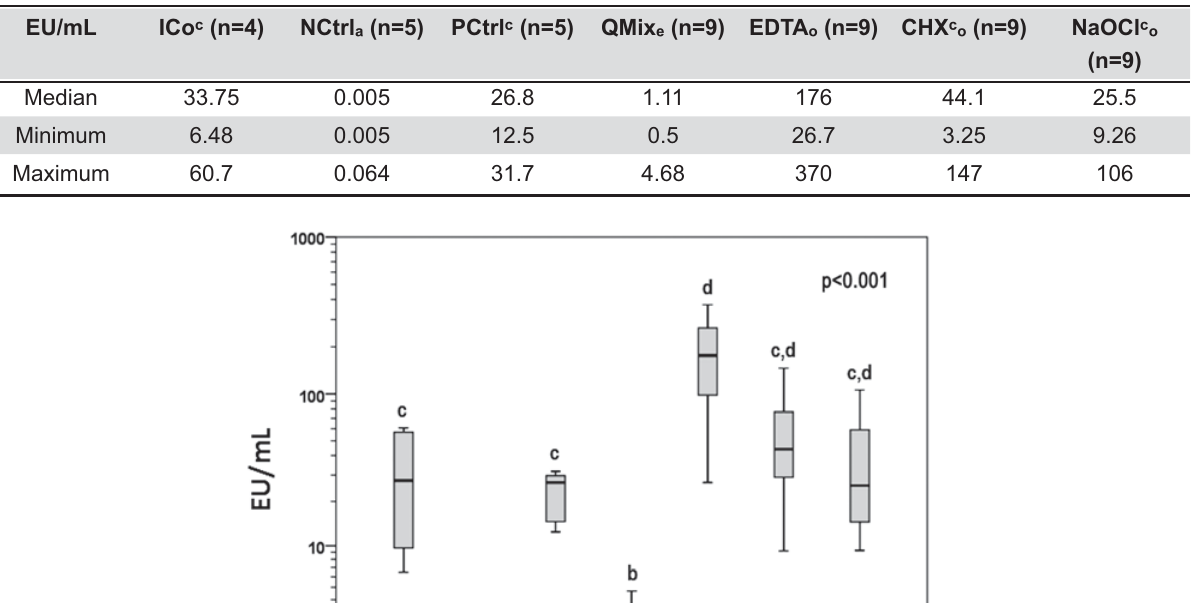
Table 1- (cid:4)&(cid:8)(cid:22)(cid:19)(cid:15)(cid:19)’(cid:7)(cid:8)(cid:4)(cid:30)(cid:10)(cid:6)(cid:23)(cid:12)(cid:20)$(cid:4)((cid:5)(cid:19))(cid:4)((cid:8)(cid:7)(cid:15)(cid:7)(cid:10)(cid:6)(cid:4)(cid:5)(cid:19)(cid:23)(cid:8)(cid:15)(cid:26)(cid:4)*(cid:5)(cid:15)(cid:14)(cid:6))(cid:4)*(cid:12)(cid:24)(cid:10)(cid:15)(cid:7)(cid:30)(cid:12)(cid:4)(cid:9)(cid:19)(cid:8)(cid:15)(cid:14)(cid:19)(cid:6)(cid:26)(cid:4)(cid:18)(cid:5)(cid:15)(cid:14)(cid:6))(cid:4)(cid:18)(cid:19)(cid:20)(cid:7)(cid:15)(cid:7)(cid:30)(cid:12)(cid:4)(cid:9)(cid:19)(cid:8)(cid:15)(cid:14)(cid:19)(cid:6)$(cid:4)(cid:13)+/$//(cid:2))(cid:4)(cid:20)(cid:7)(cid:24)(cid:8)(cid:7)(cid:27)(cid:9)(cid:10)(cid:8)(cid:9)(cid:12)(cid:4)(cid:23)(cid:20)(cid:7)(cid:8)(cid:24)(cid:4)